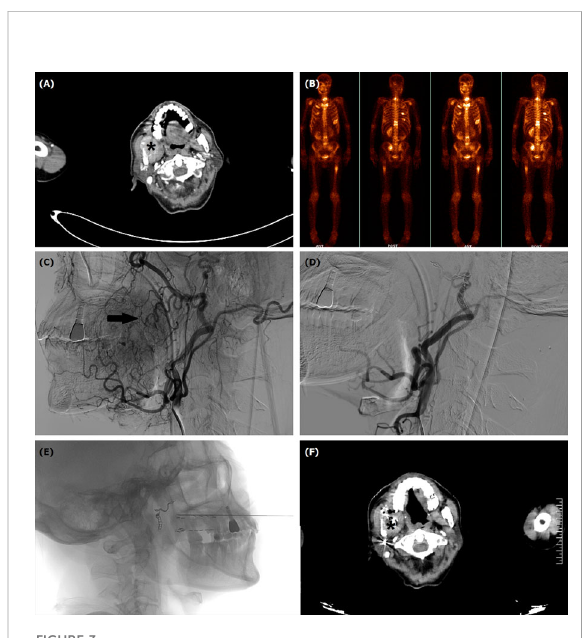
FIGURE 3 TACE for a 63-year male with oral hemorrhage due to recurrent squamous cells carcinoma in mandible and maxilla. (A) Computed tomography showed a tumor (*) in right mandible and maxilla. (B) Numerous bone metastases were visible in systemic bone imaging. (C) Tumor staining (arrow) and varies blood vessels were shown by angiography. (D) The tumor staining and tumor-feeding arteries disappeared after TACE. (E) Iodine-125 seeds implantation was performed about 1 month after TACE. (F) The tumor (*) decreased 4 months after